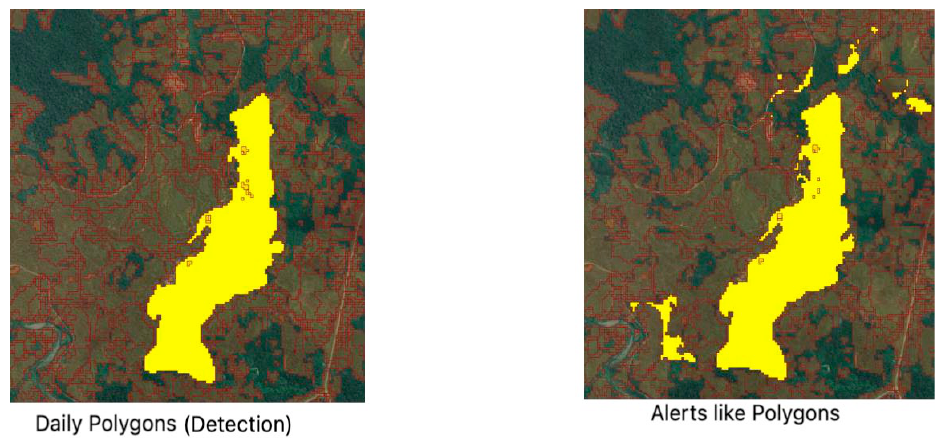
Figure 7. Daily Polygons ( left ) and Alerts ( right ).